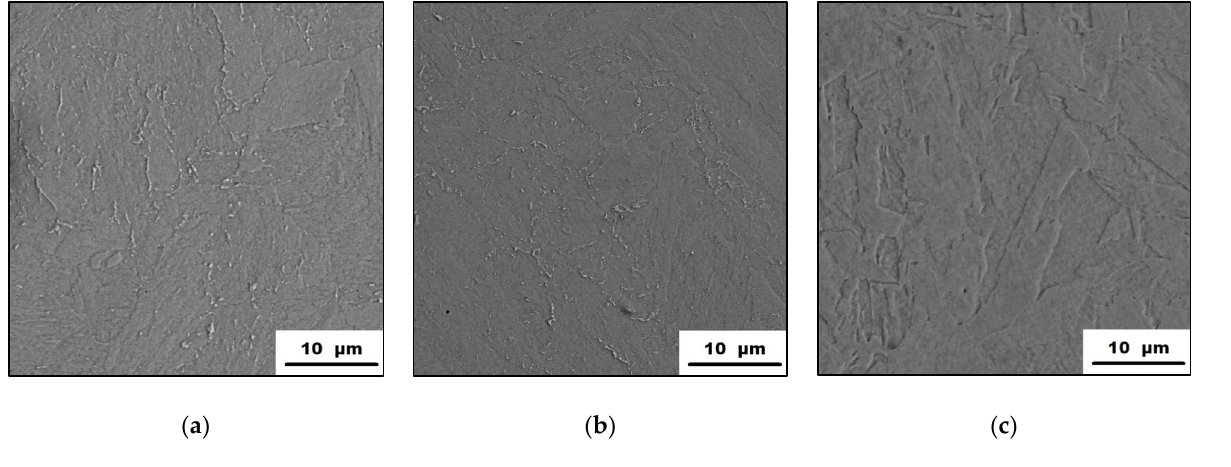
Figure 7. Microstructure characterization of the as-heat-treated 1.2709 maraging steel depending on the temperature: ( a ) as-printed; ( b ) as-printed, 500 °C; ( c ) as-printed, 900 °C (SEM).